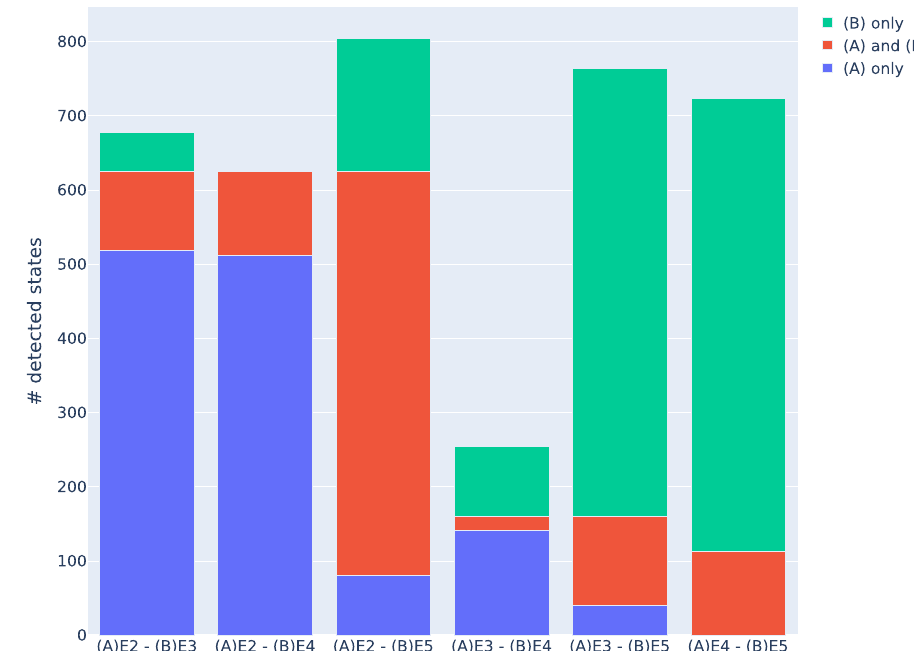
Figure 5. Pairwise comparison of number of exclusively (blue and green) and jointly (red) detected